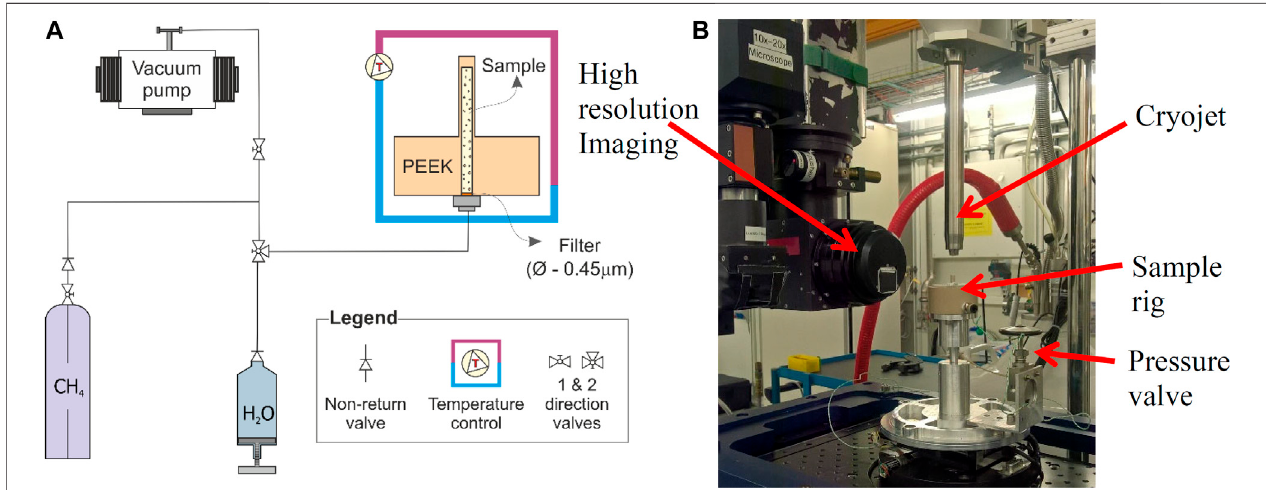
FIGURE 1 | (A) Schematic of the experimental setup; (B) Photograph of the experimental setup at Diamond Light Source, United Kingdom.